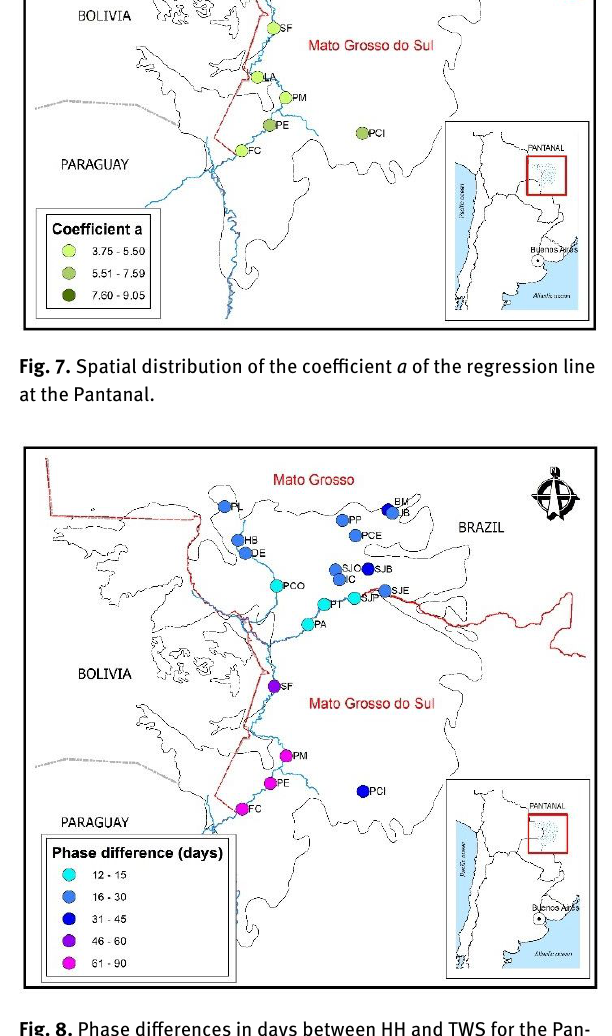
Fig. 8. Phase differences in days between HH and TWS for the Pan- tanal